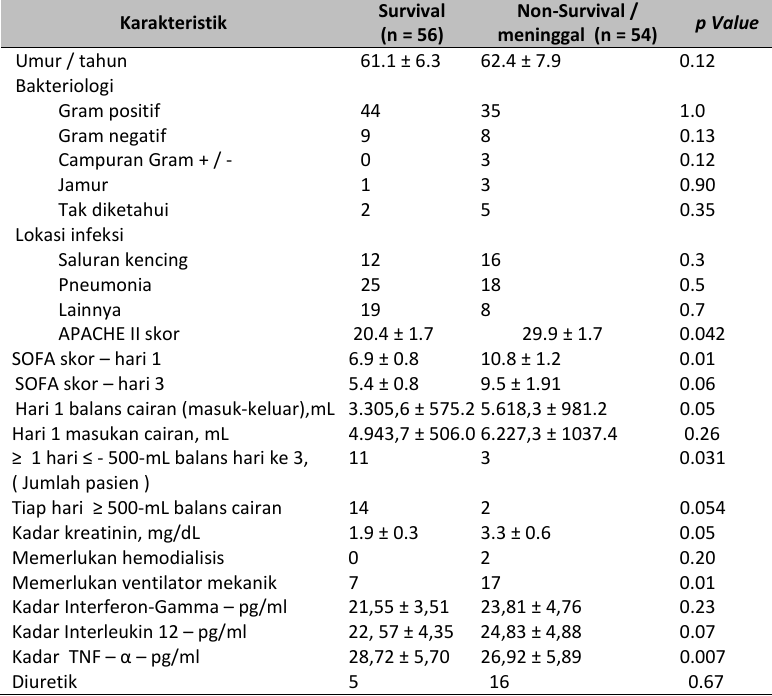
Tabel 1. Karakteristik pasien survival dan